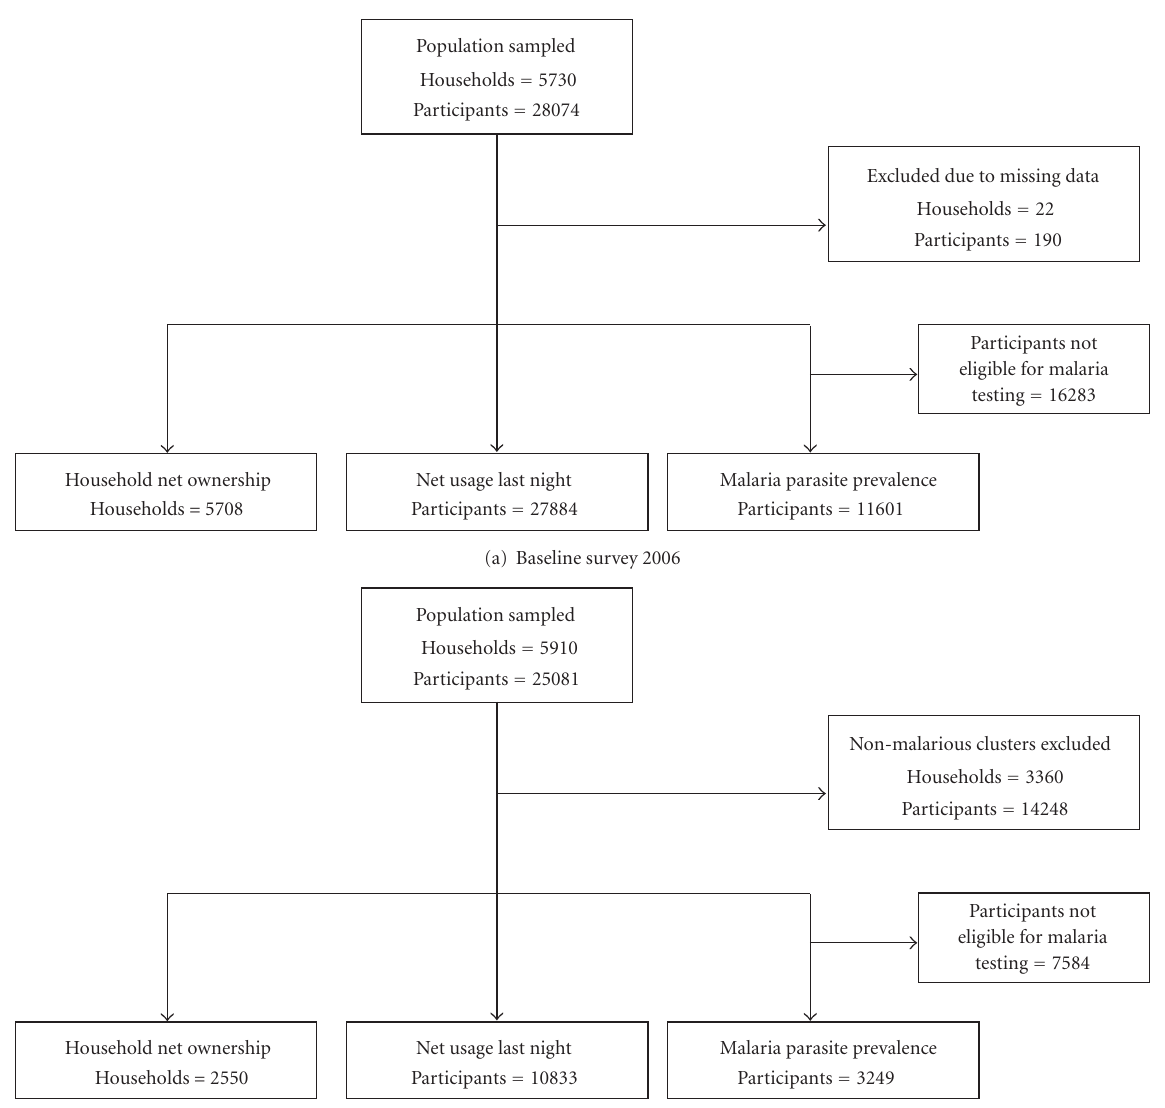
Figure 2: The sample population by